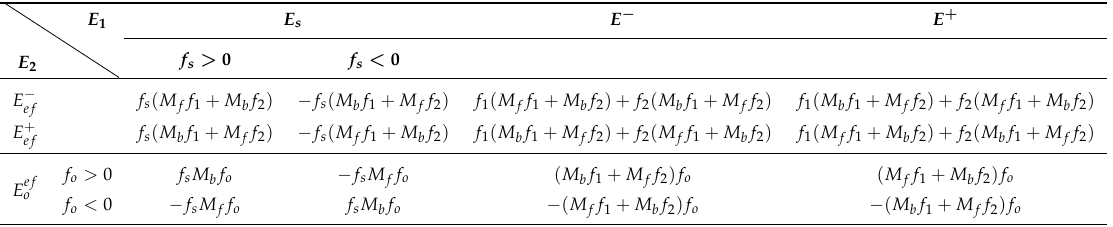
Table 3. Emission coefficients for the possible combinations of incident ( E 1 ) and emitted fluorescence ( E 2 , with notation “ef”) flux of single